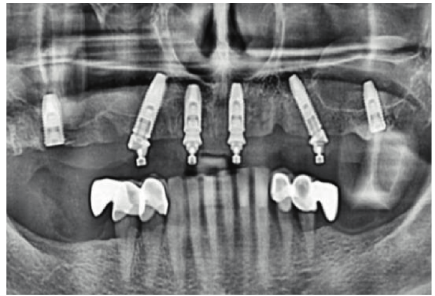
Figure 23: Radiographic control of implant integration (8 weeks).